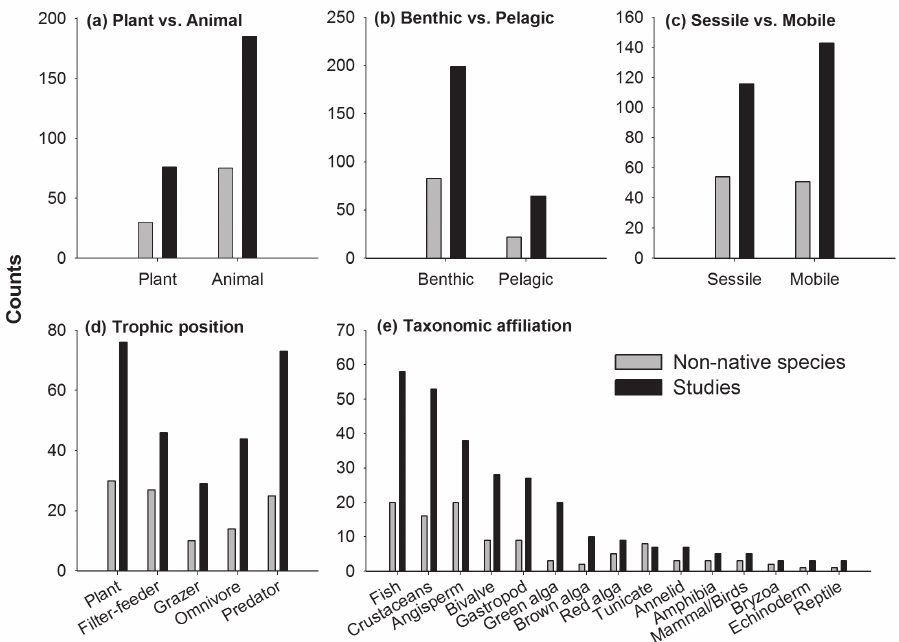
Figure 2. Aquatic invasion impact experiments classified by the attributes of the non-native species. Grey bars correspond to number of invasive species studied (total of 105 taxa); black bars correspond to the num- ber of scientific studies (total of 259 studies). Non-native species were classified as a being a plant or animal b if they occupy the benthic or pelagic realm c if they are sessile or mobile d according to their trophic position (mud-eaters were classified as herbivores, as they consume diatoms), and e taxonomic